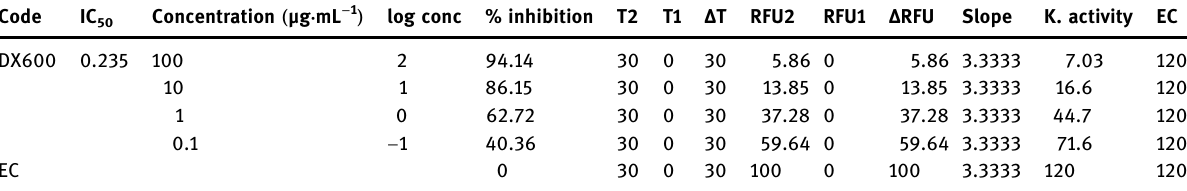
Table 2: E ff ects of DX600 ( 0.1 – 100 μ g · mL − 1 ) on ACE2 enzymatic activity